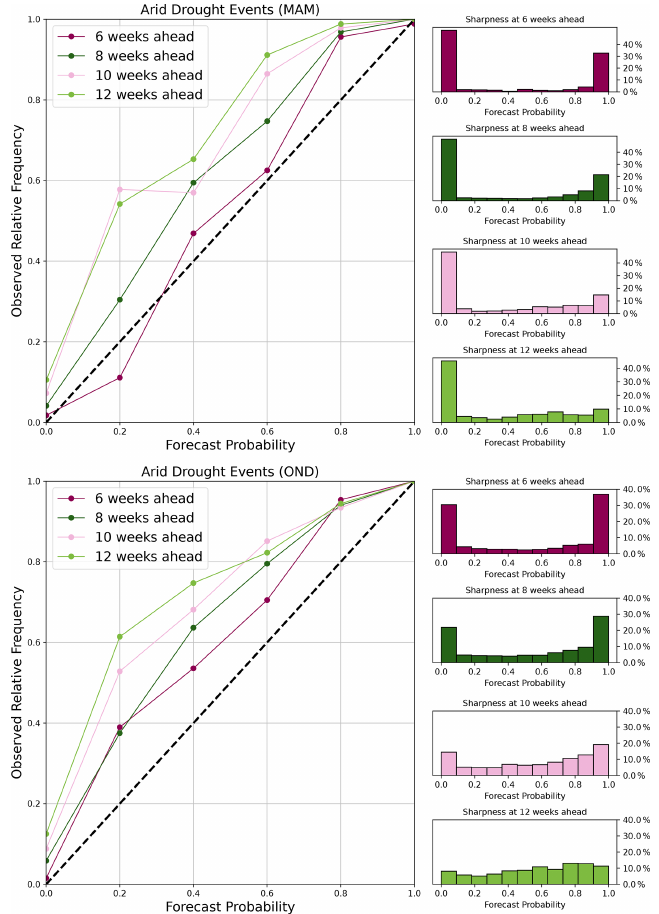
Figure 10. Reliability diagram showing forecast probability and the corresponding observed frequencies for 6-, 8-, 10-, and 12-week lead time together with their corresponding sharpness plots for drought events (VCI3M < 35) in MAM and